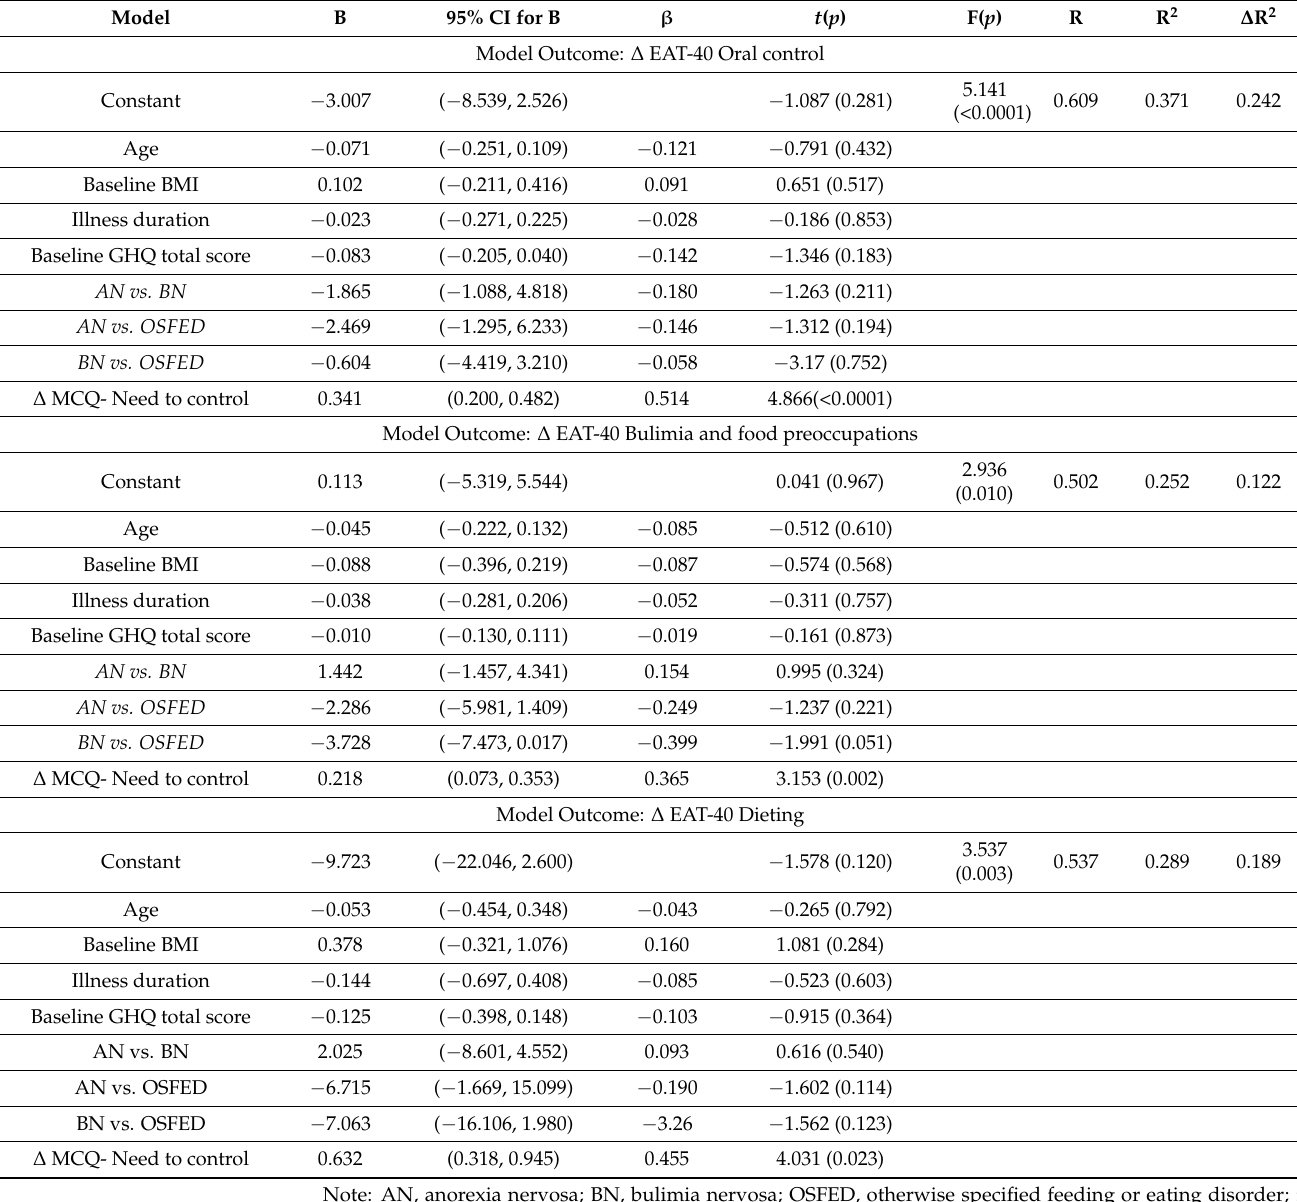
Table 2. Regression analysis for changes in metacognitions predicting changes in ED